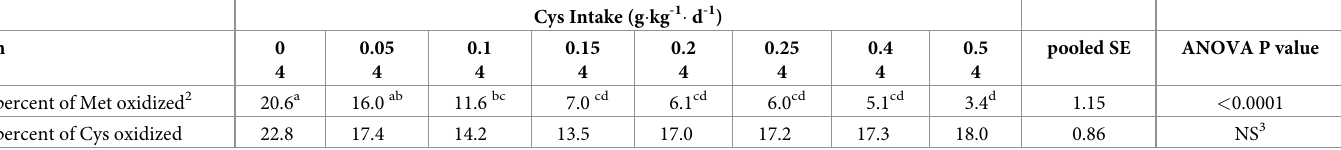
1 Values represent the means of 4 pigs per dietary Cys intake. Values represent the percent of dose oxidized at isotopic steady state. 2 Overall ANOVA, F-test, P < 0.05. Values with different superscript letters indicate a significant difference among diet levels (Student Newman Keul’s multiple comparisons procedure). 3 Non-significant (P > 0.05).